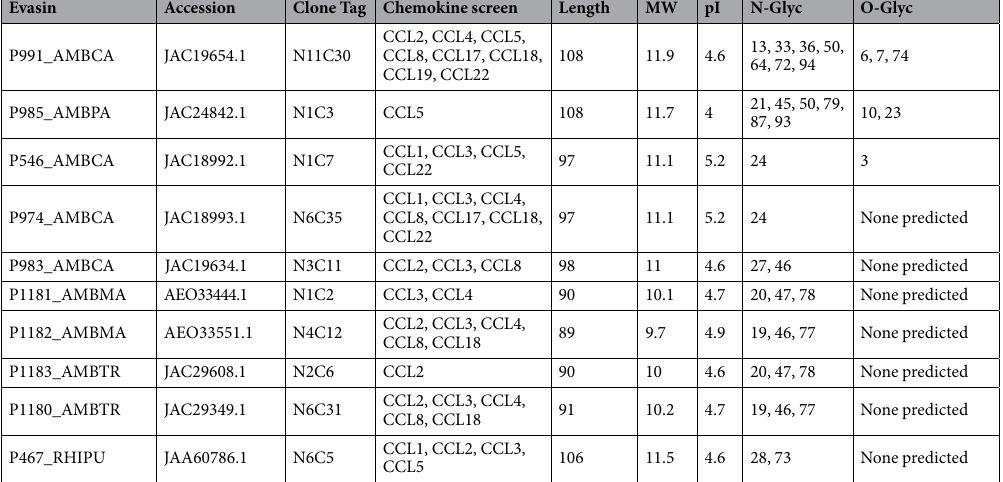
Table 1. (clone tag) is described as NXCY, where X is the number of clones recovered with the tag at the N-terminus, and Y the number of clones recovered with the tag at the C-terminus. Abbreviations: MW – molecular weight (KDa), N-Glyc – predicted N-glycosylation sites, O-Glyc - predicted O-glycosylation sites. Length refers to number of amino acid